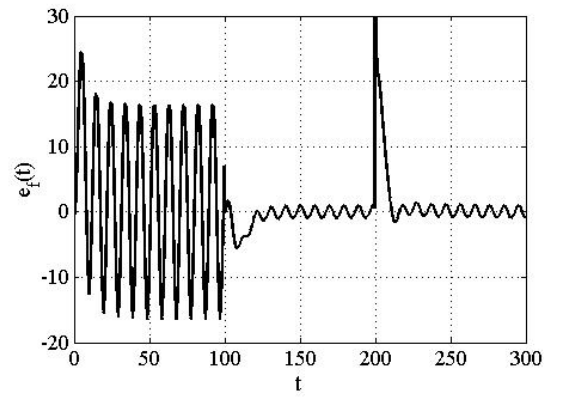
e t (error of fault estimation) generated by Figure 2. Signal ( ) f the basic adaptive observer (0–100 s) and corrected one with estimation of fault at 200